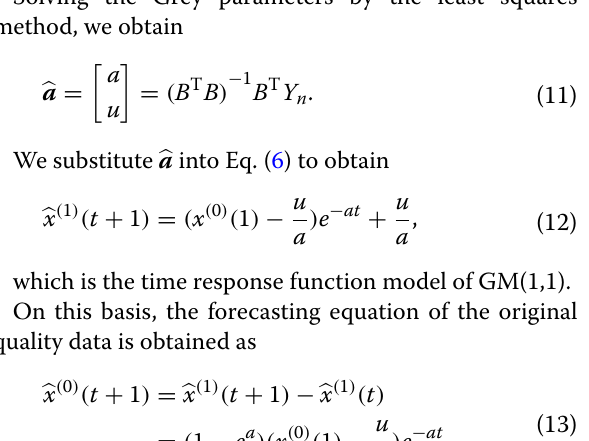
which is the time response function model of